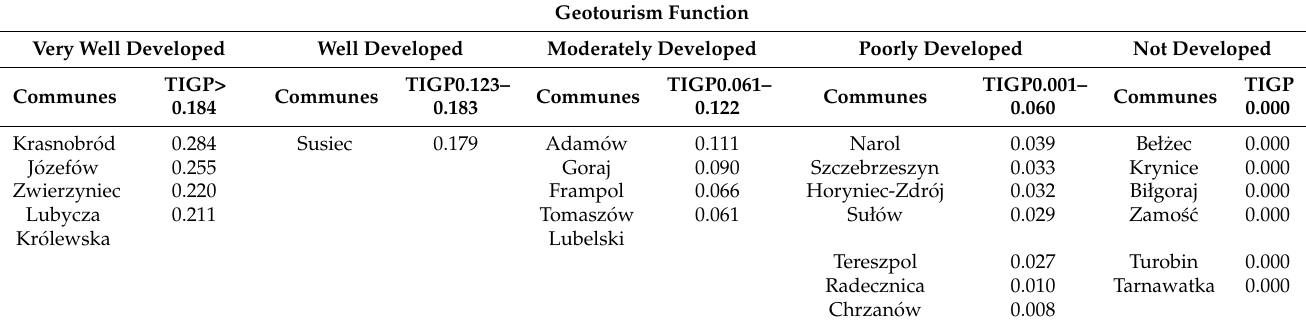
Table 11. Diversity of the geotourism function of communes located within the Roztocze TBR shown by the Total Geotourism Function Index,